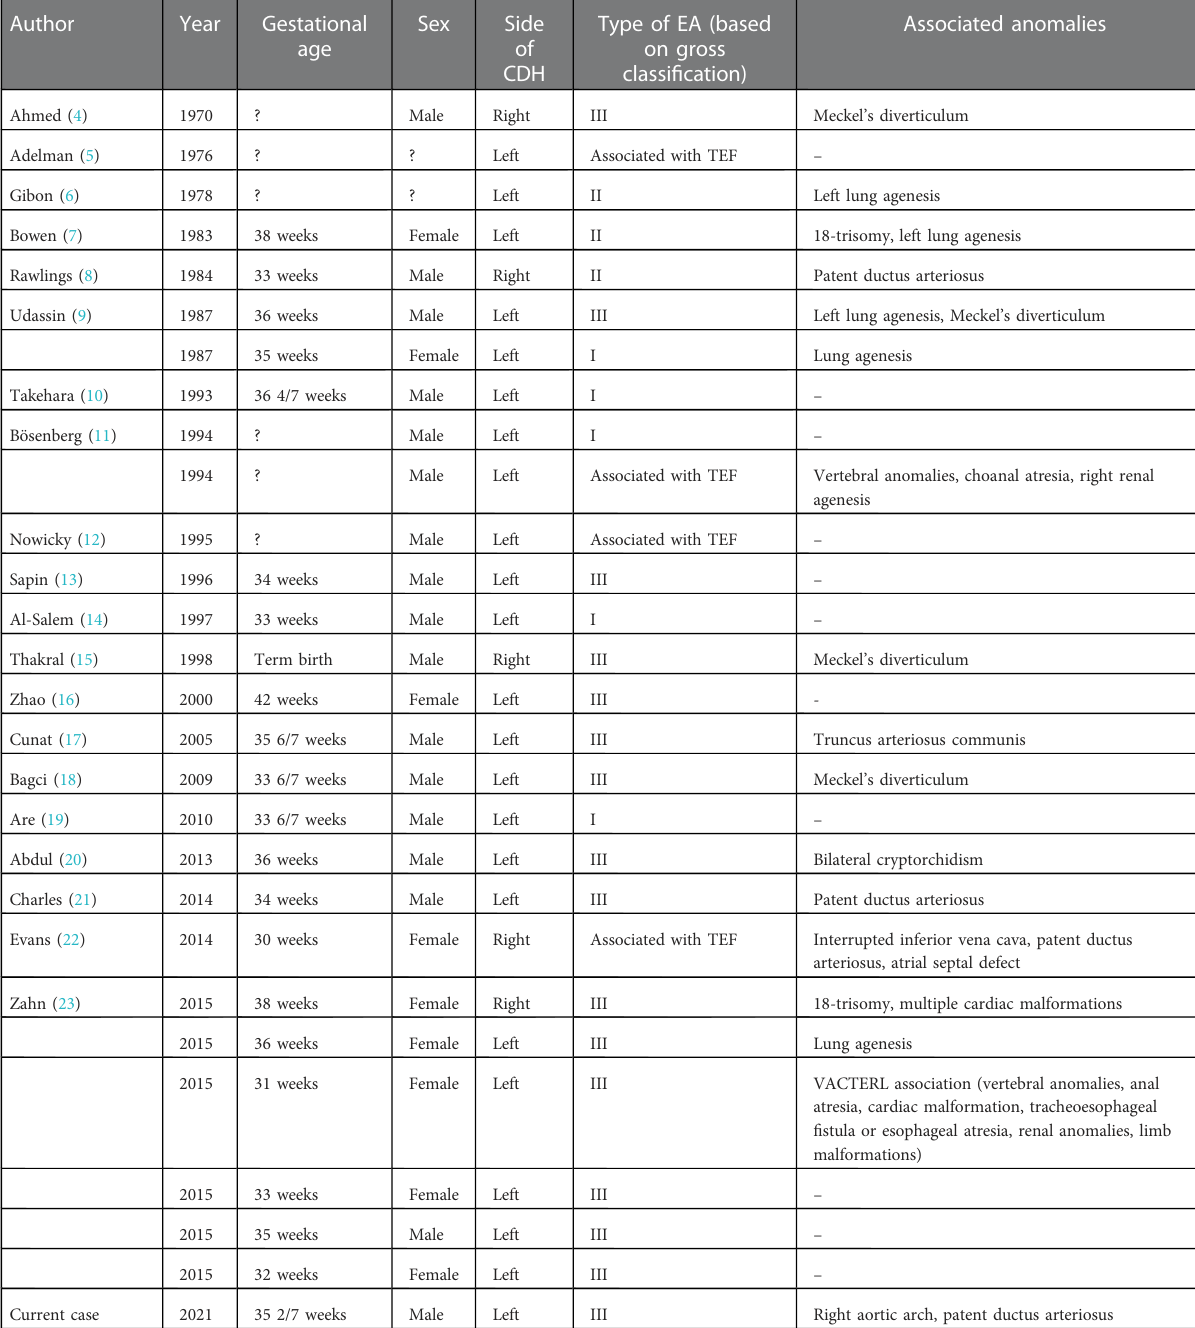
TABLE 1 Summary of fi ndings of CDH associated with EA or EA and